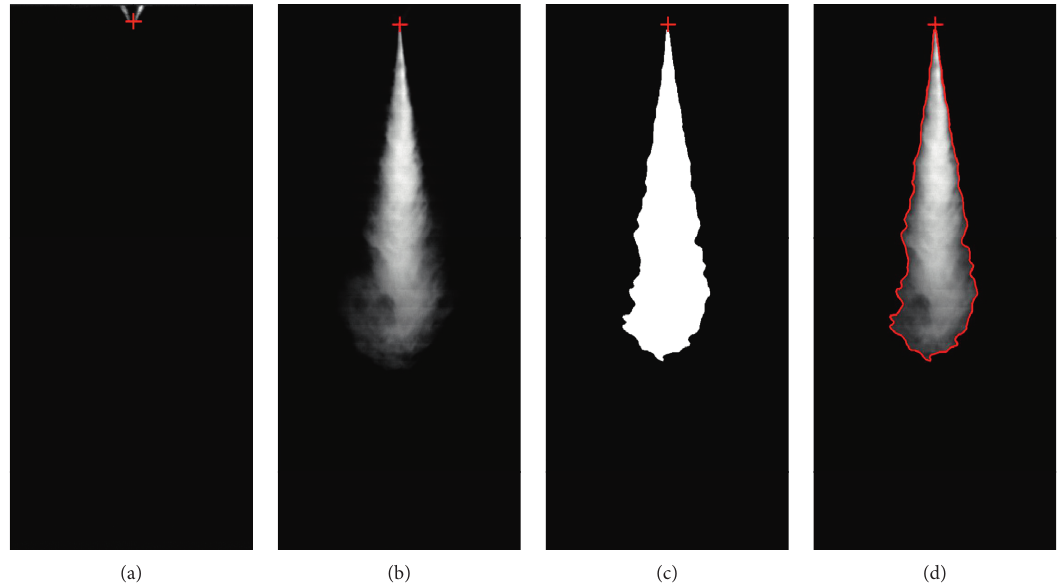
Figure 2: Image process for Mie scattering. (a) Average image for background. (b) Raw image subtracting background. (c) Binary image. (d) Filter